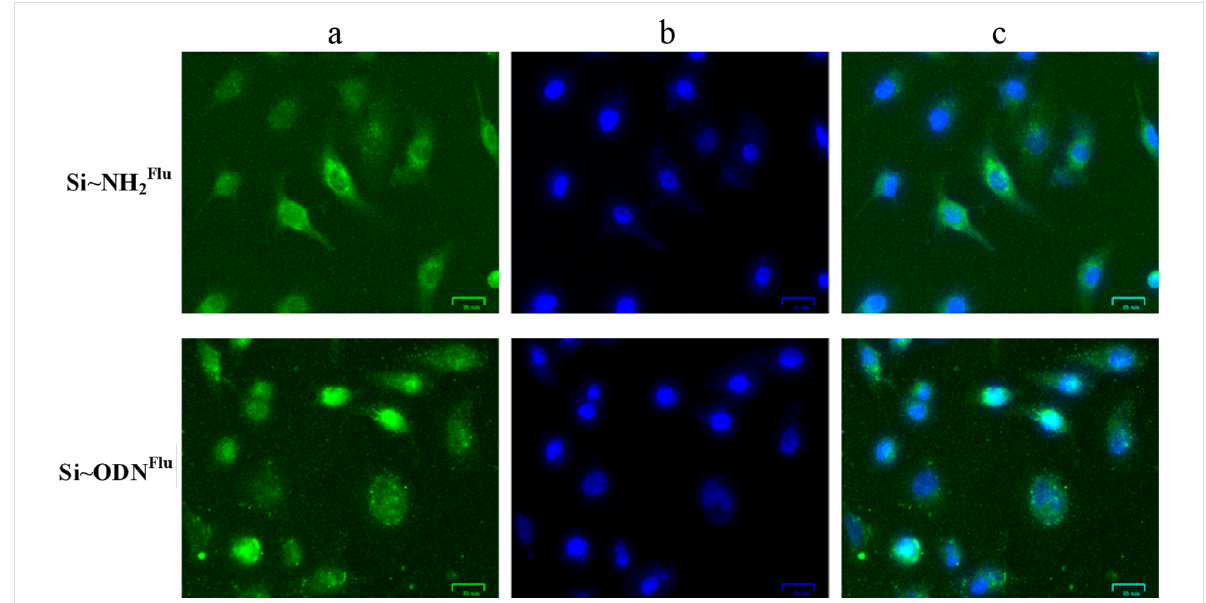
Figure 5: Fluorescence microscopy images of A549 human lung adenocarcinoma cells after their incubation with Si–NH 2Flu nanoparticles and Si–NH 2 ·ODN(3) Flu nanocomplexes. Fluorescein-labeled samples were detected in the green channel (488 nm) (a); DAPI-stained cell nuclei were detected in the blue channel (405 nm) (b); the superposition of all channels is shown in (c). The scale bar for all images corresponds to 25 μ m.